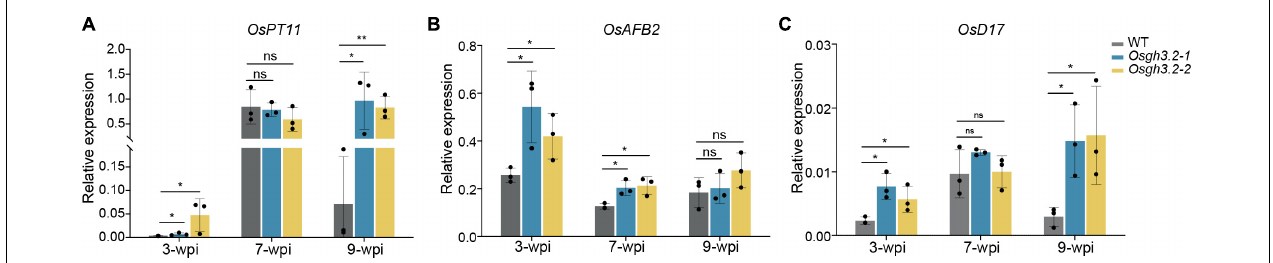
FIGURE 6 | The expression patterns of OsPT11 , OsAFB2 , and OsD17 at 3-, 7- and 9-wpi by R. irregularis in roots of wild-type rice and the Osgh3.2 mutants. (A–C) Relative expression levels of OsPT11 , OsAFB2 , and OsD17 were measured by qRT-PCR experiments. A housekeeping gene, OsUBI1 , was used for normalization. Data represent mean ± standard deviations (SD) of three biological replicates. Statistical analysis was performed with Student’s t -test (ns, not significant; * P ≤ 0.05; ** P ≤ 0.01).